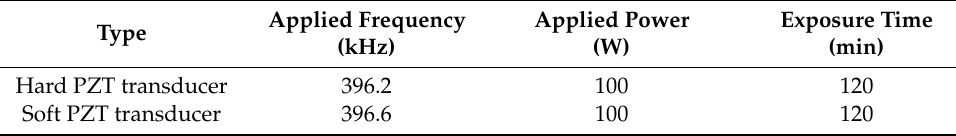
Table 4. Physical properties of the nanoparticles, solvent, and suspension used in the experiment.